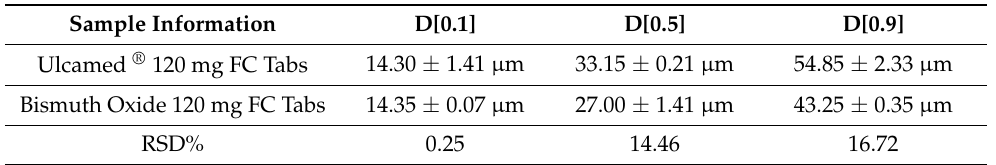
Table 5. Average PSD values of bismuth oxide API using micro-Raman spectroscopy in Ulcamed ® 120 mg FC Tabs against tested Bismuth Oxide 120 mg FC